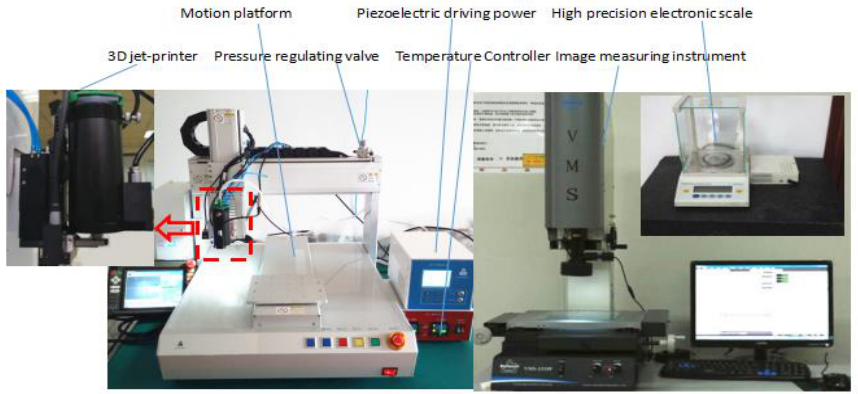
Figure 13. Jet printing test bench.